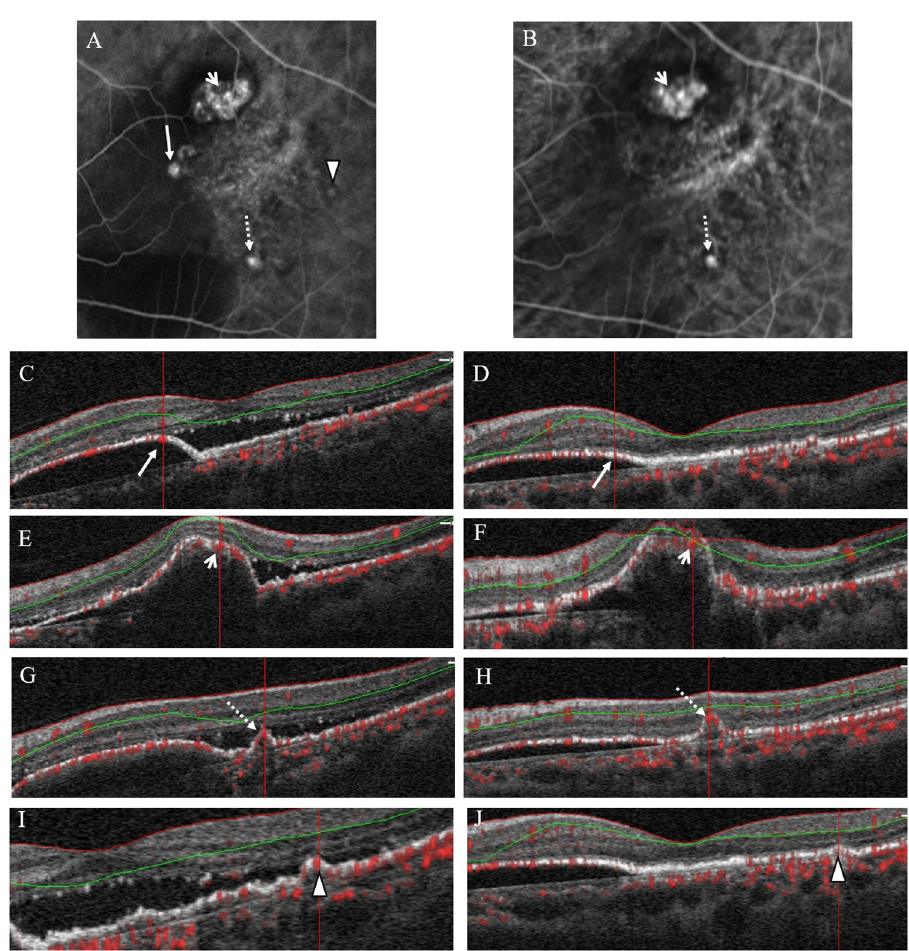
Fig 5. ICGA and OCTA of case 6. (A) ICGA before treatment showed 4 polyps, labeled as polyp 9 (long arrow), polyp 10 (short arrow), polyp 11 (dotted arrow) and polyp 12 (arrowhead). (B) ICGA after the treatment showed complete regression of polyp 9 and 12, but the persistence of polyp 10 (short arrow) and polyp 11 (dotted arrow). (C) OCTA of polyp 9 before treatment showed the presence of flow signal (arrow) but (D) the absence of flow signal (arrow) after treatment. Note that the adjacent signal was projection artifacts from the retinal vessels. (E) OCTA of polyp 10 before and (F) after treatment showed the presence of flow signal (short arrow). (G) OCTA of polyp 11 before and (H) after treatment showed the presence of flow signal (dotted arrow). (I) OCTA of polyp 12 before treatment showed the presence of flow signal (arrowhead) but (J) the absence of flow signal (arrowhead) after